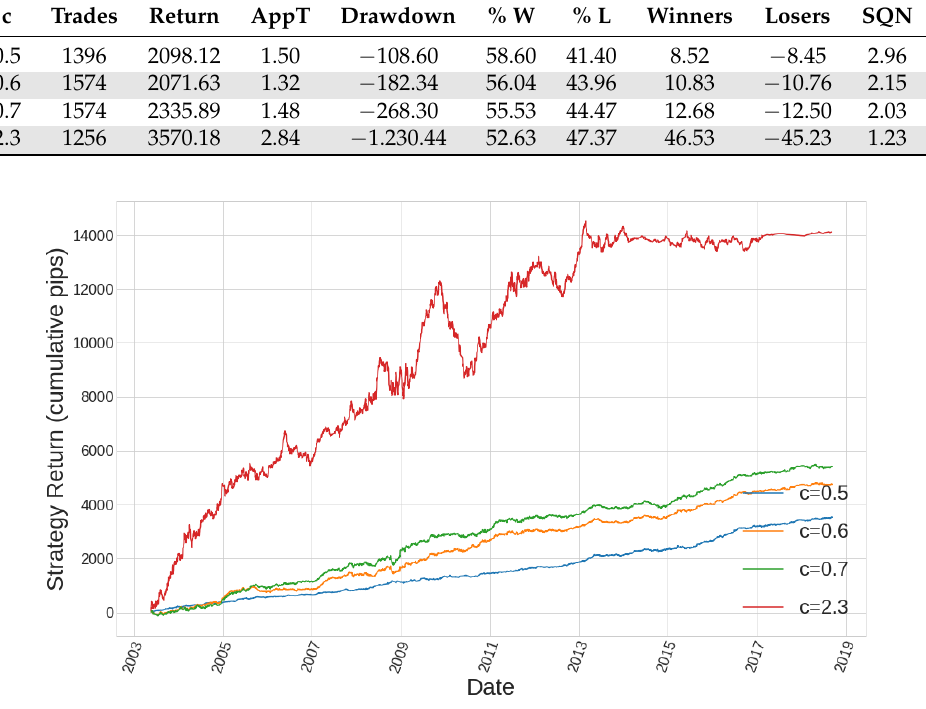
Figure 15. The difference between the average winning pips per trade is clear, although they all follow similar curves due to similar choices of optimum candlestick patterns.